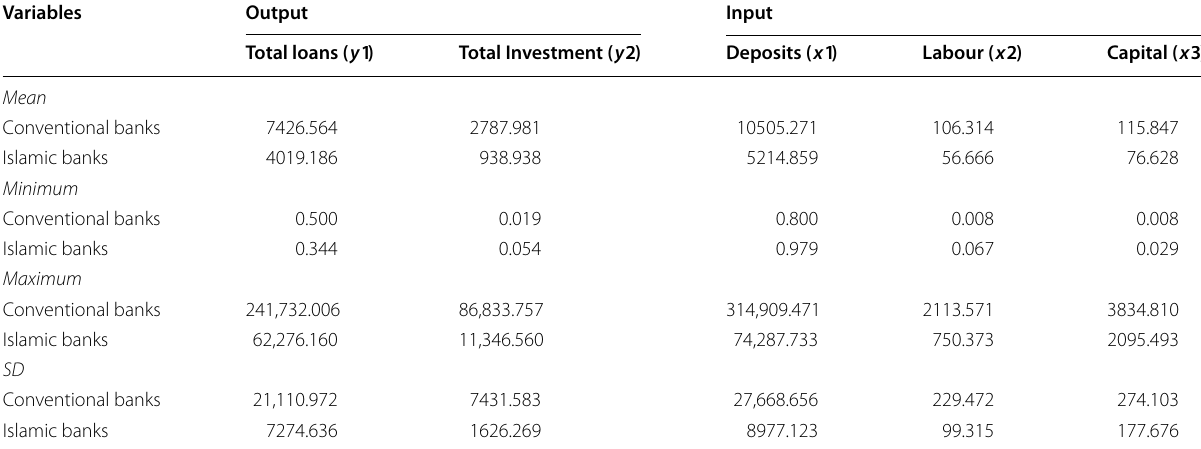
y 1 (total of short-term and long-term loans); y 2 (total securities); x 1 (total deposits, money market and Short-term Funding); x 2 (personnel expenses); x 3 (fixed assets)